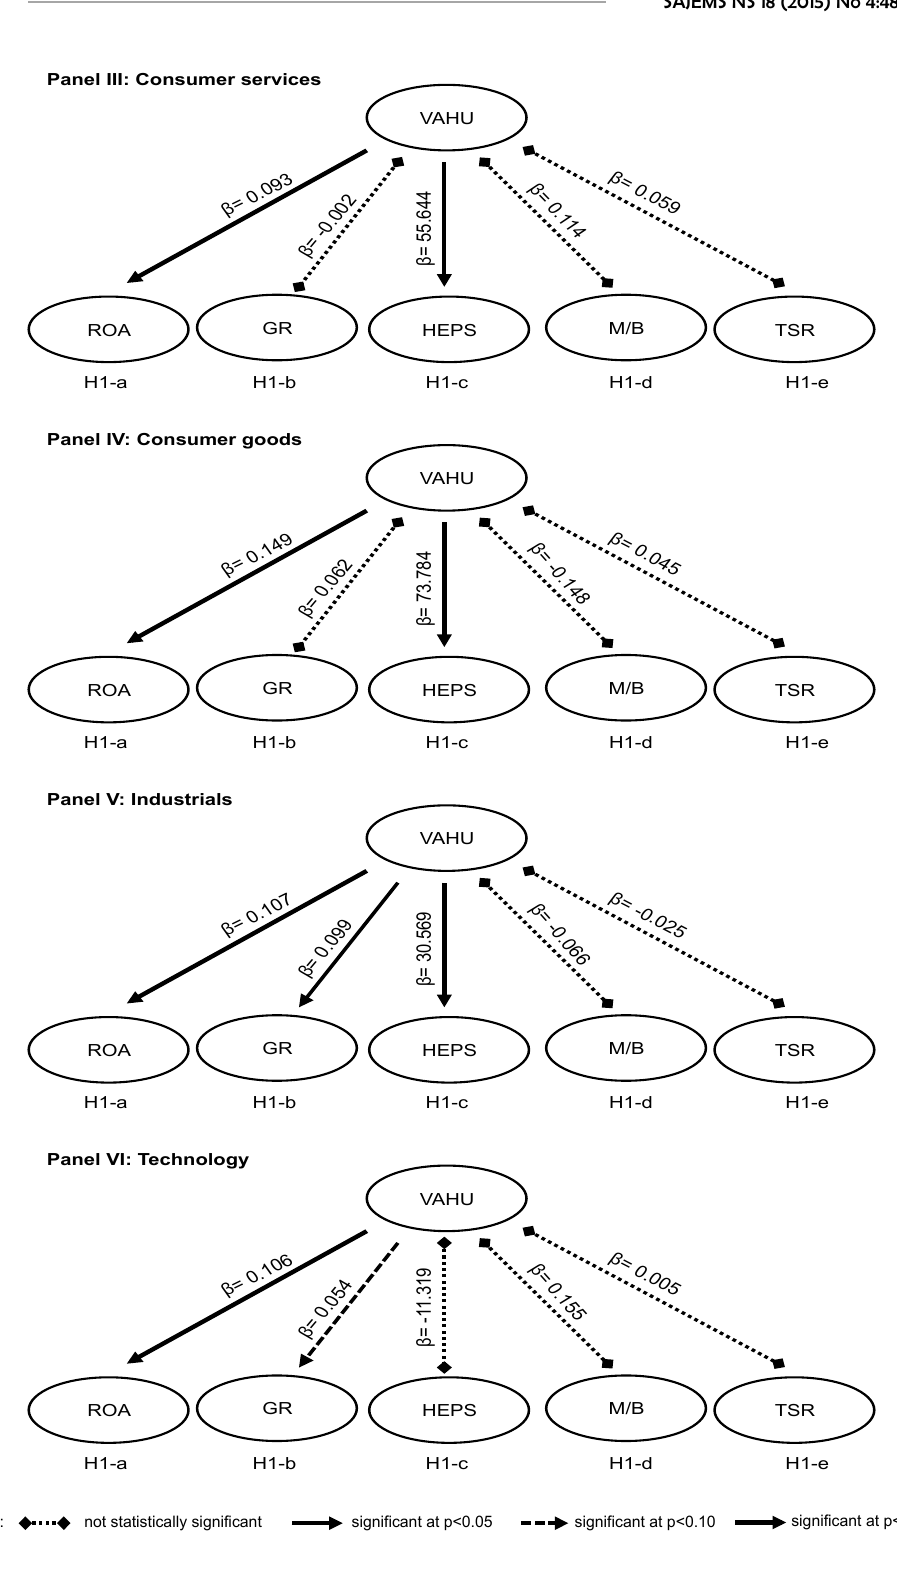
not statistically significant significant at p<0.05 significant at p<0.10 significant at p<0.01